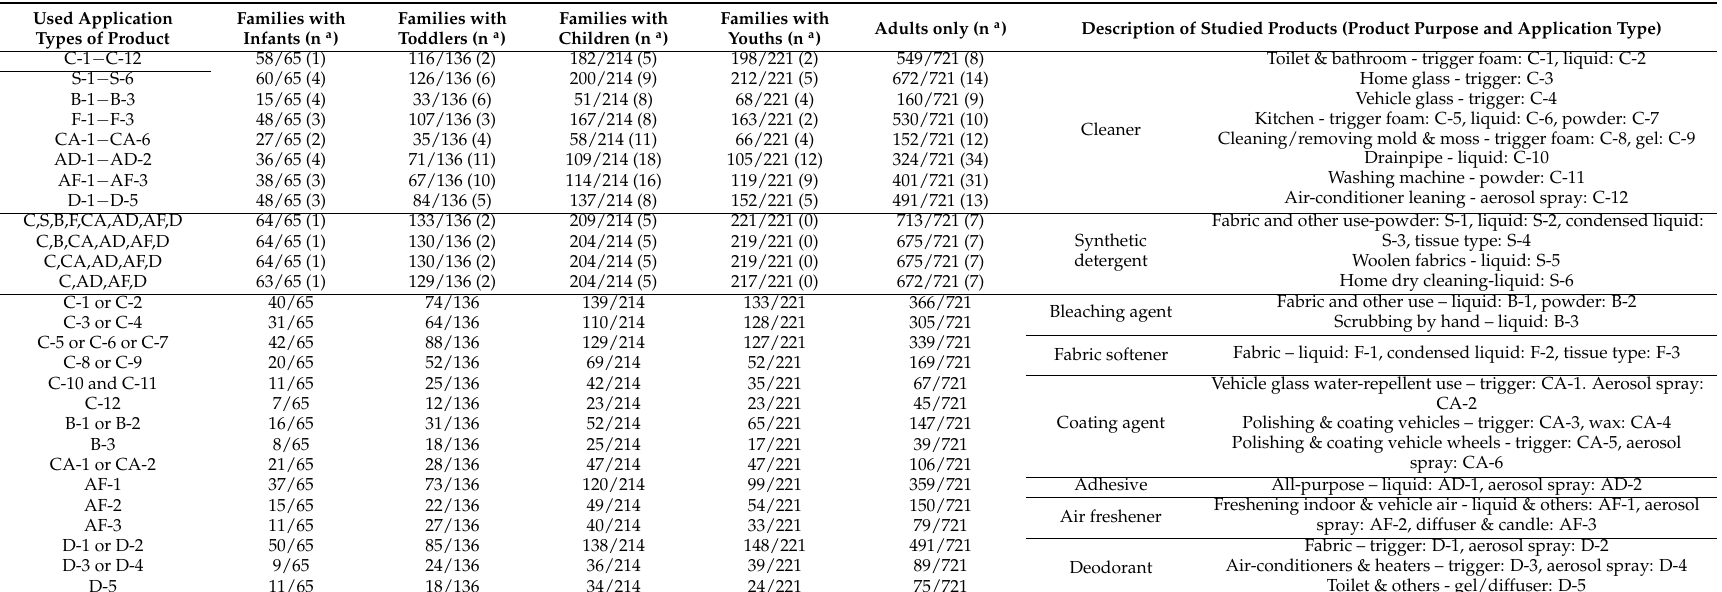
Table 1. Distribution of products used by surveyed